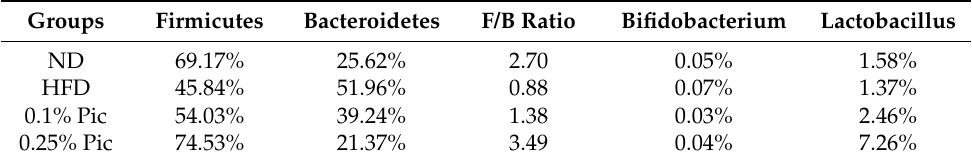
Figure 7. Effect of piceatannol supplementation on the gut microbiota in HFD-fed C57BL/6 mice. ( A ) Phylum classification; ( B ) Order classification. Genomic DNA was extracted from stool samples and identified by the NGS method. Table 2. Effect of piceatannol supplementation on gut microbiota in HFD-fed C57BL/6 mice. The main phyla and probiotic genera Bifidobacterium and Lactobacillus are shown.